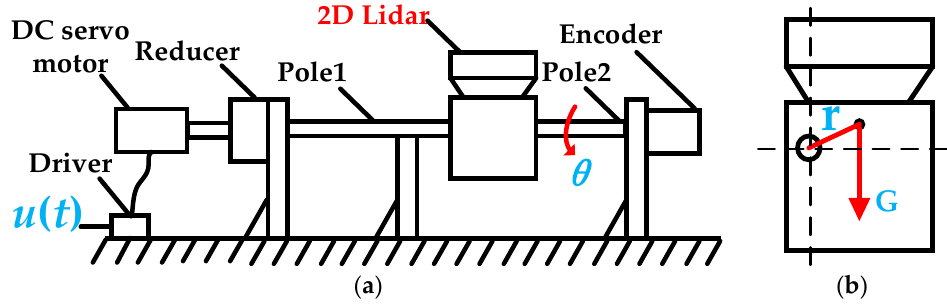
Figure 2. ( a ) Schematic diagram of the 3D laser scanning system; ( b ) schematic diagram of the Lidar’s gravity center and rotation center.